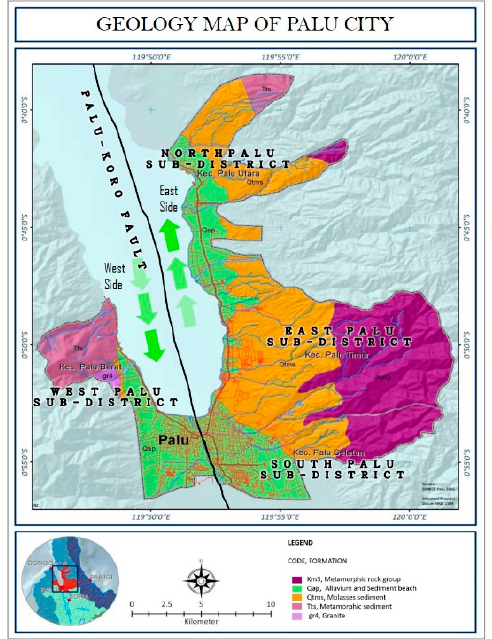
Figure 2. Geological map of Palu, Indonesia, which has five main geological structures: the metamorphic group, alluvium and sediment beach group, molasse sediment, metamorphic sediment, and granite. The map also shows the Palu ‐ Koro fault, which caused the earthquake in Palu. Modified from [35].